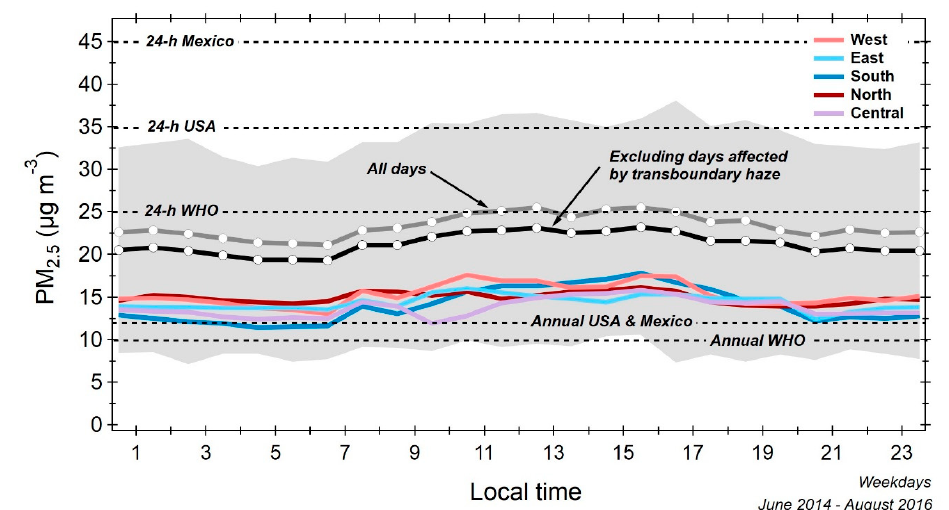
Figure 15. Diurnal pattern of PM 2.5 ambient concentrations during weekdays for each of the five regions in which Singapore is divided for air quality purposes, excluding the days affected by transboundary haze. The black and grey curves show to the mean maximum concentrations recorded across the whole island on days no affected and affected by transboundary haze, respectively. All diurnal patterns correspond to the geometric mean obtained from the 1-hour data published by NEA between June 2014 and August 2016. The shaded area indicates the day-to-day variability as the ±1 standard deviation of the hourly maximum concentrations on days not affected by haze.